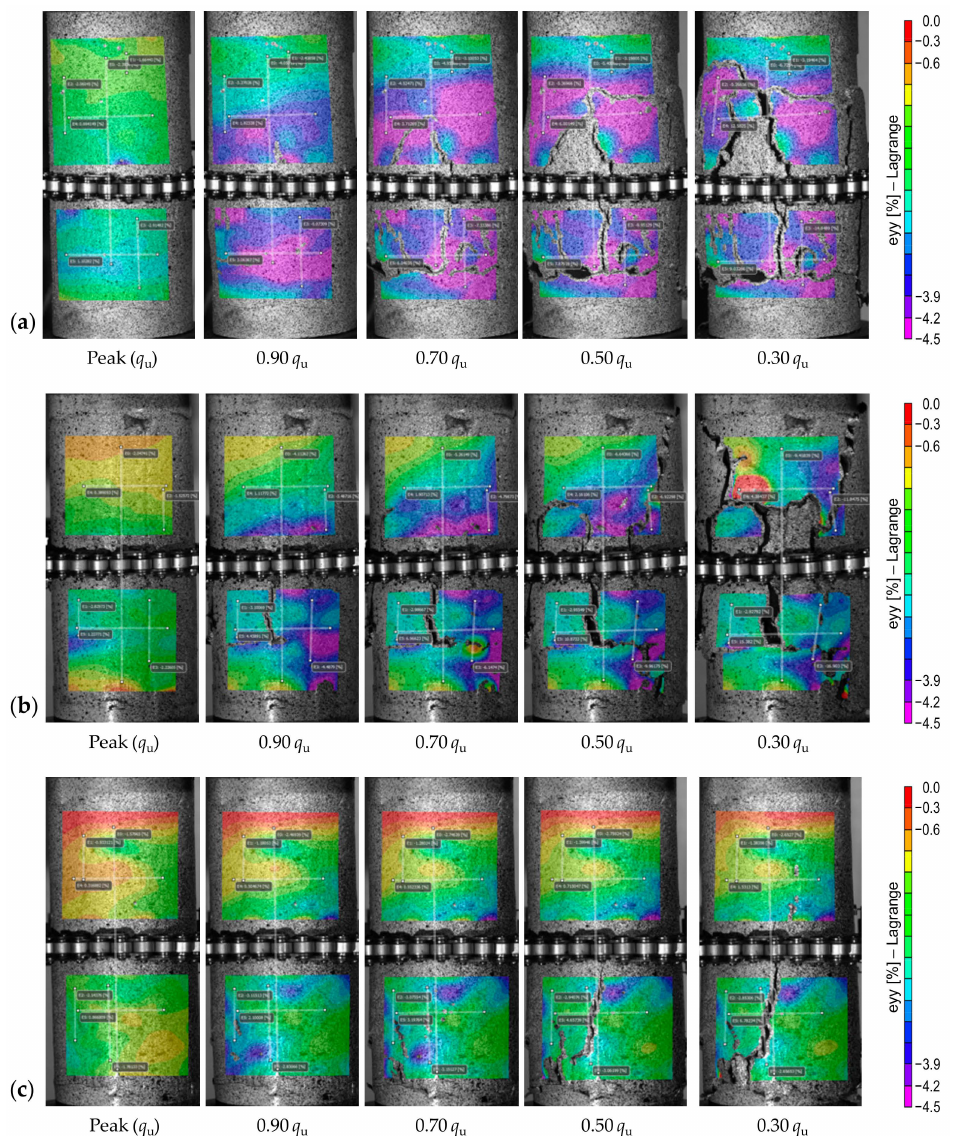
Figure 8. E ff ect of curing time on strain localization—field of axial strains developed at various post-peak axial stress levels: ( a ) P 4 F 0 T 14 ; ( b ) P 4 F 0 T 28 ; and ( c ) P 4 F 0 T 56